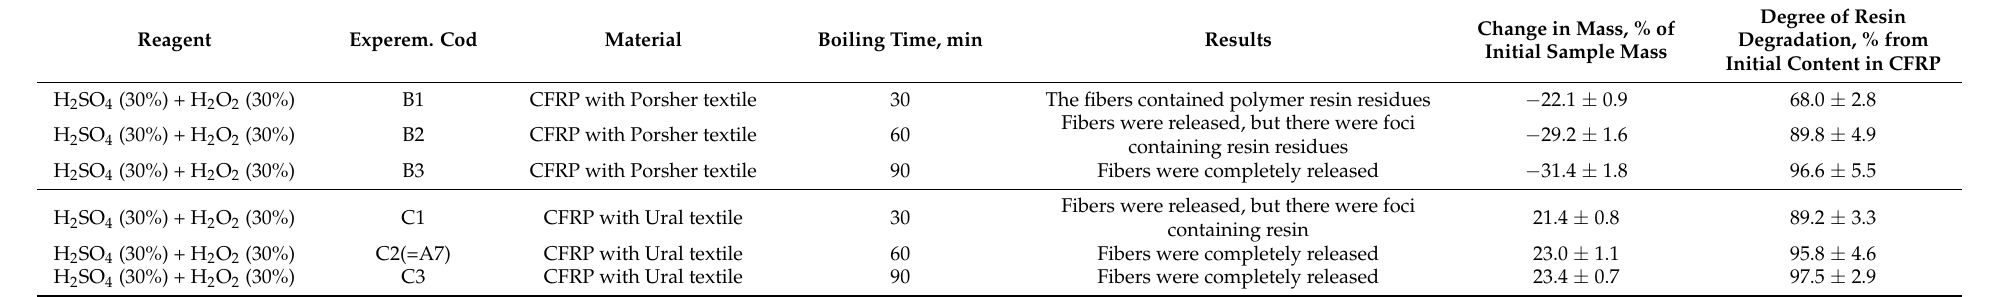
Table 3. Results of fiber extraction by solvolysis (Stage 2: The influence of carbon fabric weaving and the duration of the process on solvolysis